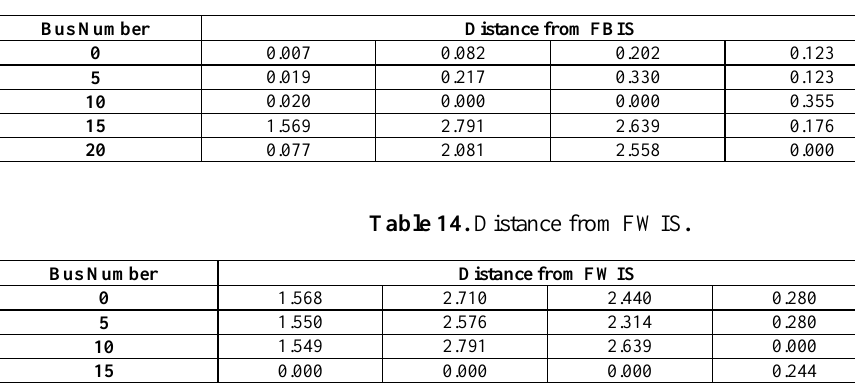
Table 13. Distance from FBIS .